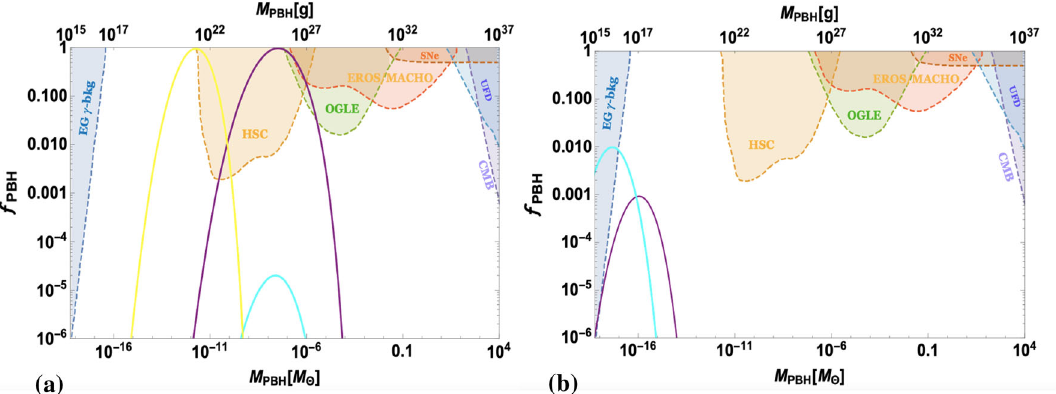
Fig. 6 Left panel: for q = 1 and n = 1, dark matter fraction ( f PBH ) as a function of the primordial black hole mass ( M PBH ) in the unit of M (cid:2) is plotted. Three different colors correspond to three differ- ent values of potential parameter x , m . Purple color corresponds to x = − 2 . 14990 , m = 1 / 25, yellow is for x = − 1 . 17090 , m = 3 / 50 and cyan stands for x = − 1 . 69995 , m = 1 / 20. Right panel: for q = 1